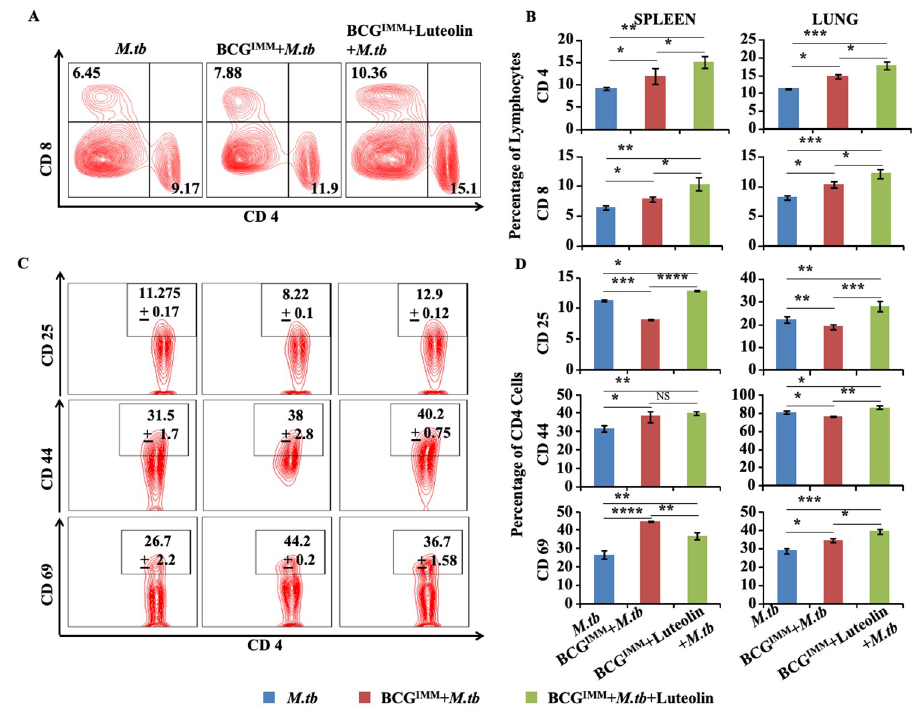
Fig 3. Luteolin promotes T cell responses in BCG-immunized mice. (A) Representative FACS plots and (B) combined data showing the proportion of CD4 + & CD8 + T lymphocytes in spleen and lung of mice of the indicated study groups at 60 days post-infection. (C) Representative FACS plots and (D) combined data showing activation profile of CD4 + T cells in spleen and lung of infected mice of the indicated study groups at 60 days post-infection. Data represented as the mean ± STDEV values from data pooled from three experiments with five mice per experiment. Differences were considered significant at P < 0.05 using one way ANOVA. � p < 0.05, �� p < 0.005, ��� p < 0.0005.